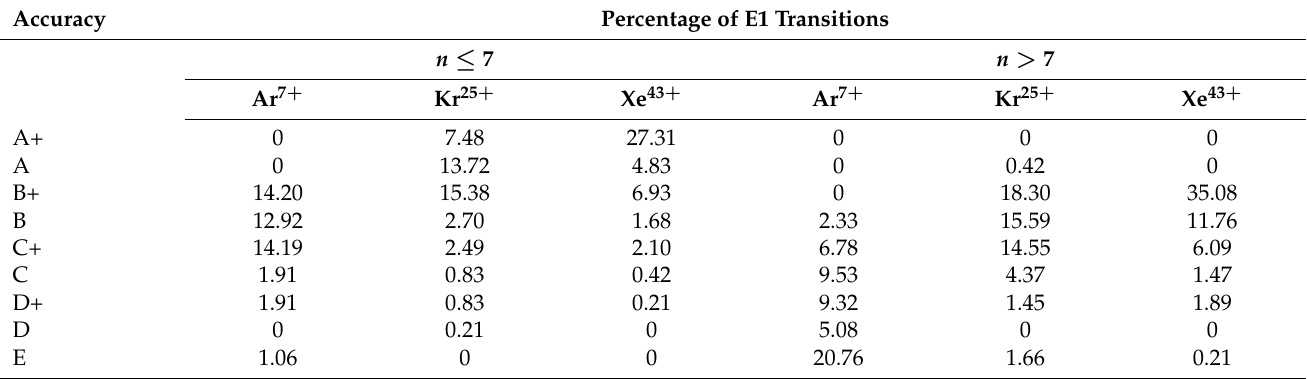
Table 5. Percentage of E1 transitions with uncertainty